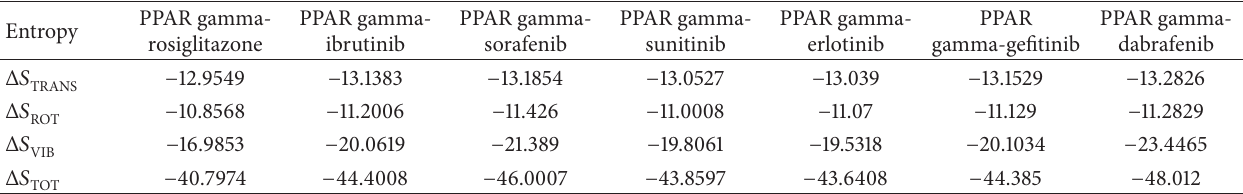
Table 4: Calculated entropy contributions by quasi-harmonic approximation for PPAR gamma-TKI’s and PPAR gamma-rosiglitazone complexes by MM-GBSA.